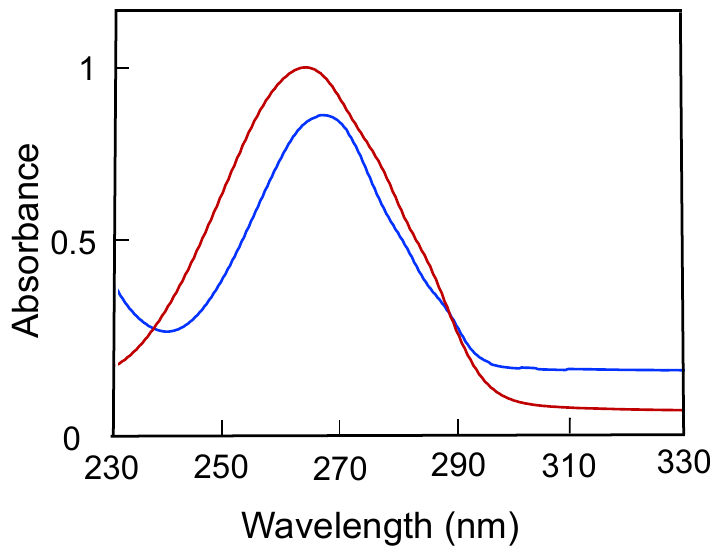
Figure 2. UV absorbance spectra of AzPEG750 [5] (red) and 4-azidobenzoic acid (blue) in ethanol/water (0.1 wt.%).